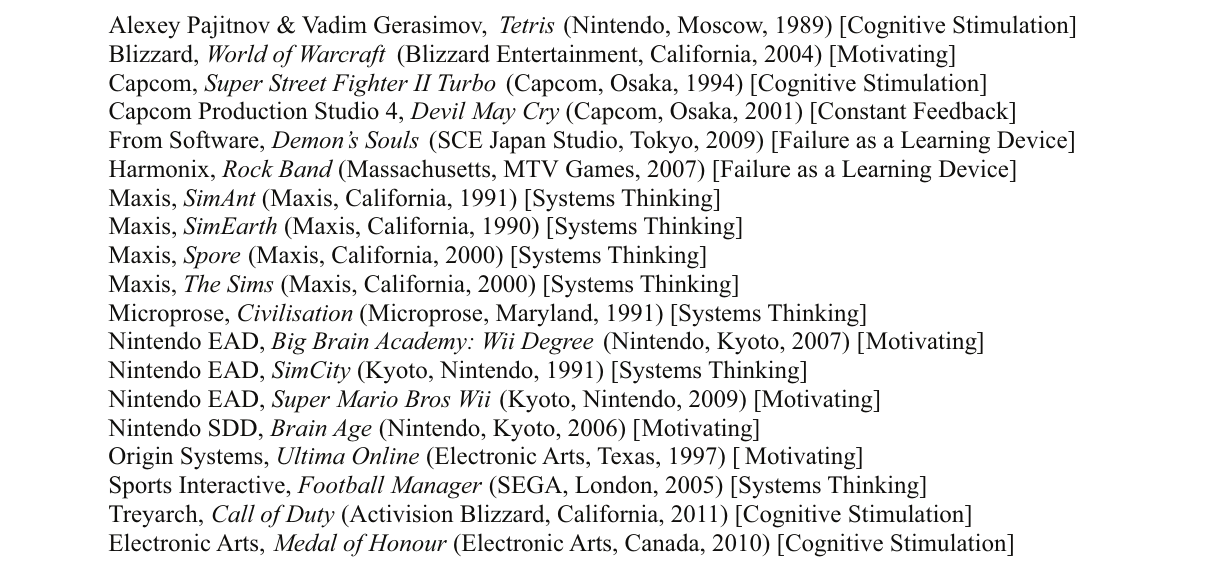
Figure 1 | A summary compendium of various COTS with the learning themes that each game best fits within indicated in the square